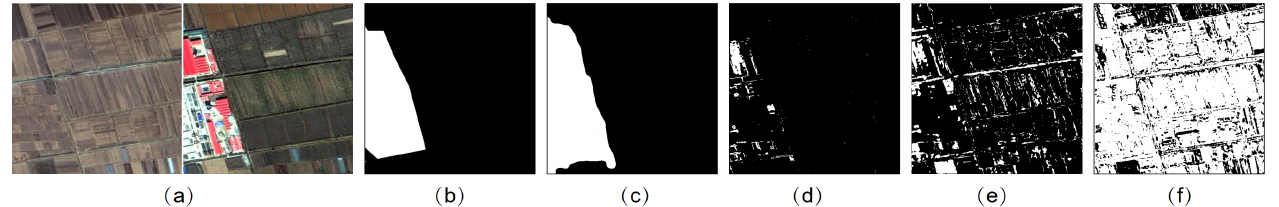
Figure 4. The change detection task on one image pair with the proposed method and the SCCN. ( a ) The given image pair. ( b ) The label mask. ( c ) The result of our method. ( c – e ) are the results of the SCCN with λ = 0.1,0.15,0.17, respectively. Table 3. Detection results on one